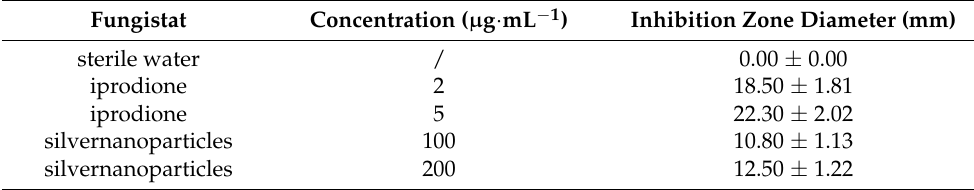
Table 3. Inhibition zone diameter of iprodione and silver nanoparticles.